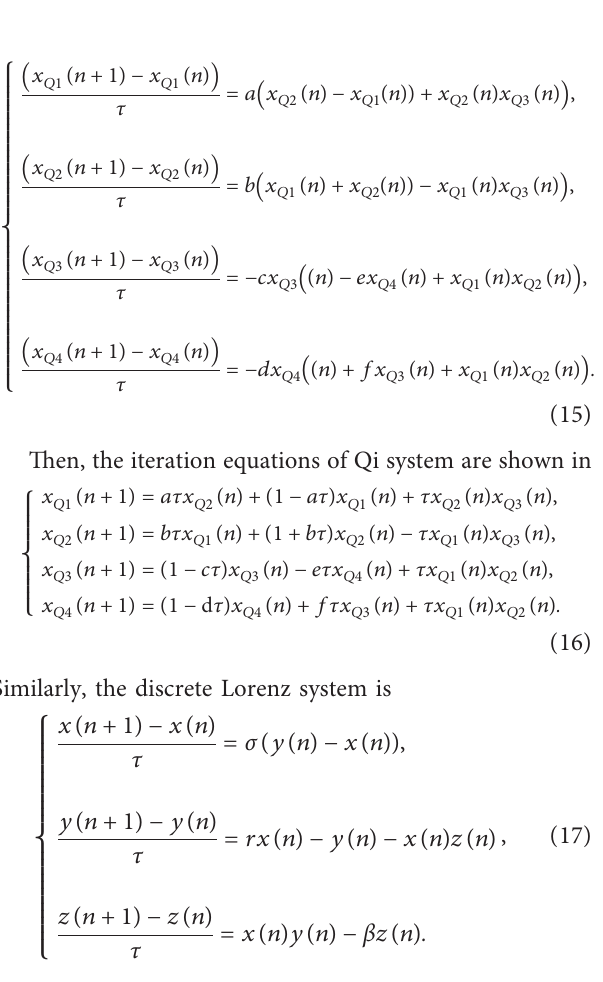
Figure 1: Bifurcation diagram along with b variation and partial phase portraits for different initial values (blue line for the first initial value set and red line for the second initial value set).